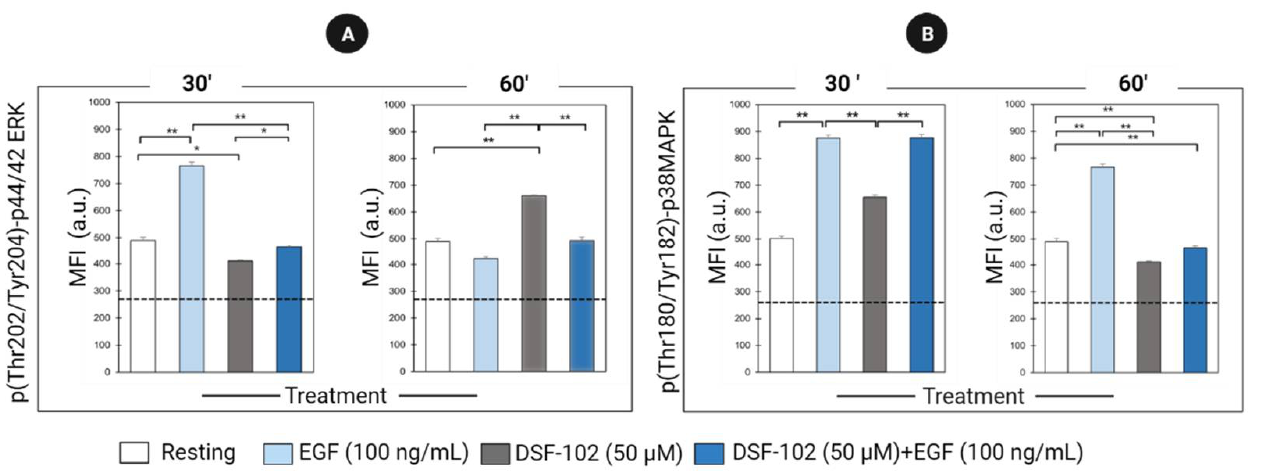
Figure 7. Flow cytometry analysis of DSF-102 activity on EGFR signaling. ( A ) p44/42 ERK and ( B ) p38 MAPK activation at 30 and 60 min following the co-administration of DSF-102 (50 μM) and EGF (100 ng/mL). Samples treated with only EGF or DSF-102 , and resting cells were used as con- trols. Data were expressed as MFI ± SEM. * ( p ≤ 0.05); ** ( p ≤ 0.01).